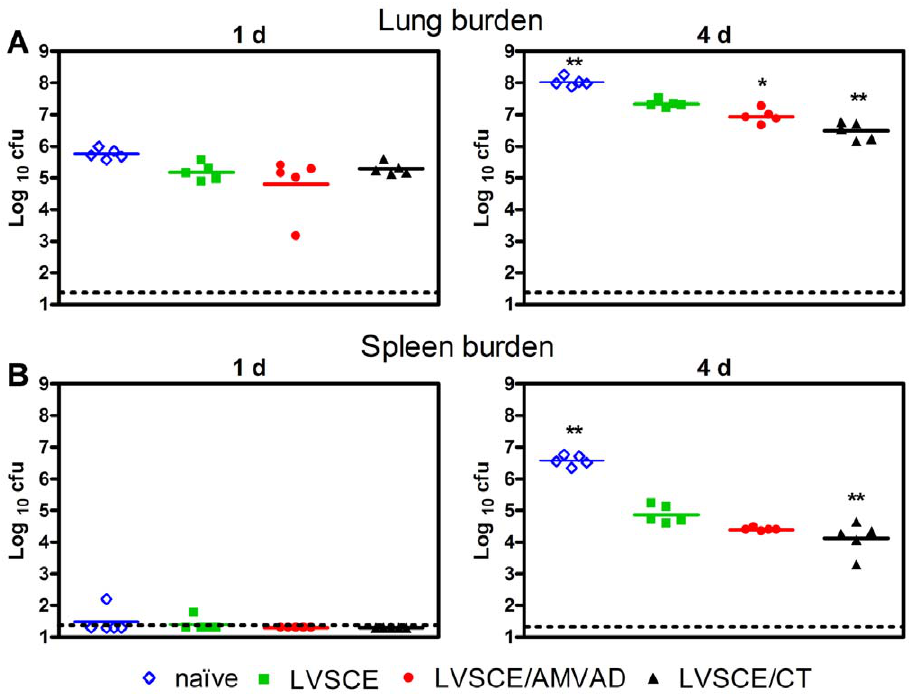
Figure 5. LVSCE/AMVAD vaccine reduces the bacterial burdens in the lungs and spleen. Five mice per naı¨ve, and LVSCE, LVSCE/AMVAD or LVSCE/CT immunized groups challenged with 3.4 6 10 4 cfu of F. tularensis LVS in the Figure 4 experiment were euthanized at 1 or 4 d post-challenge, and the F. tularenisis burden (log 10 cfu/organ) in the lungs (A) and spleen (B) determined. The data are presented as mean log 10 cfu 6 SD for each group, at each time point (n=5). The dotted line represents the detection limit. * p , 0.05 and ** p , 0.01 vs. LVSCE alone immunized group. Data are representative of two separate experiments.